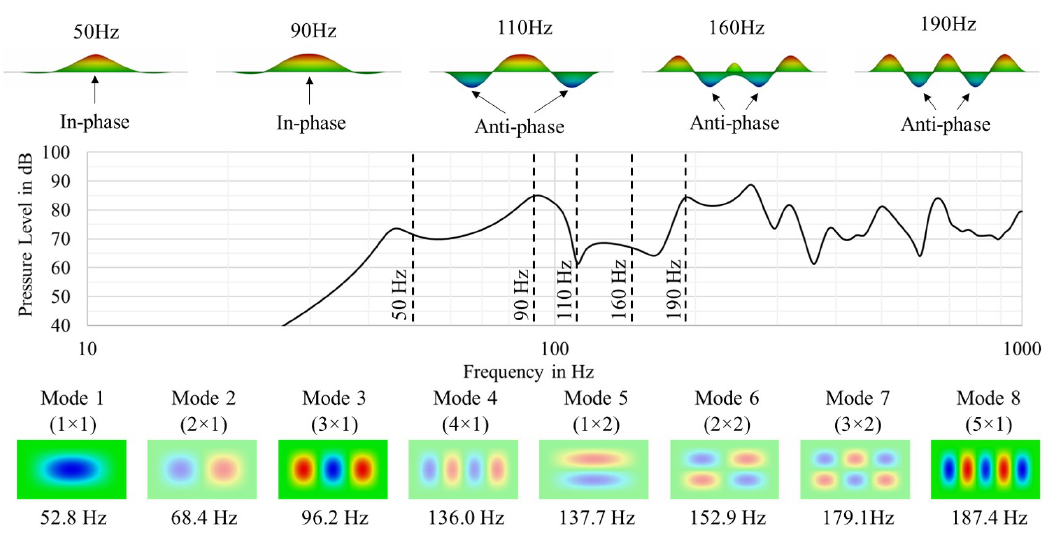
Figure 6. Simulated pressure response of the standard prototype with the visualization of the front displacement at discrete frequencies in the upper part. In the lower part, an overview of the relevant modes is presented. All even modes are not excited by the central